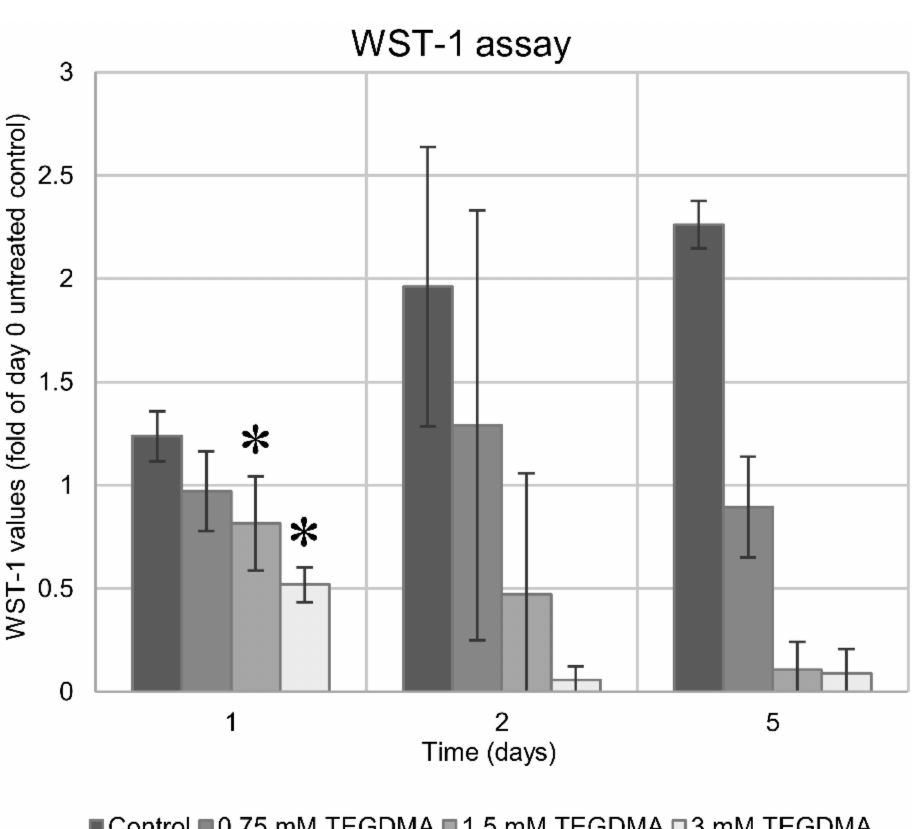
Figure 6. Viability changes in pulp cells over the course of the 5-day exposure to 0.75, 1.5, and 3 mM TEGDMA as detected by the Water-Soluble Tetrazolium-1 assay. The graph depicts viability values as a ratio relative to the untreated cells at the start of the experiment. * = significantly different from the 1st day untreated control ( P = 0.0293, 0.0004 for 1.5 mM and 3 mM, respectively, sample number: n =